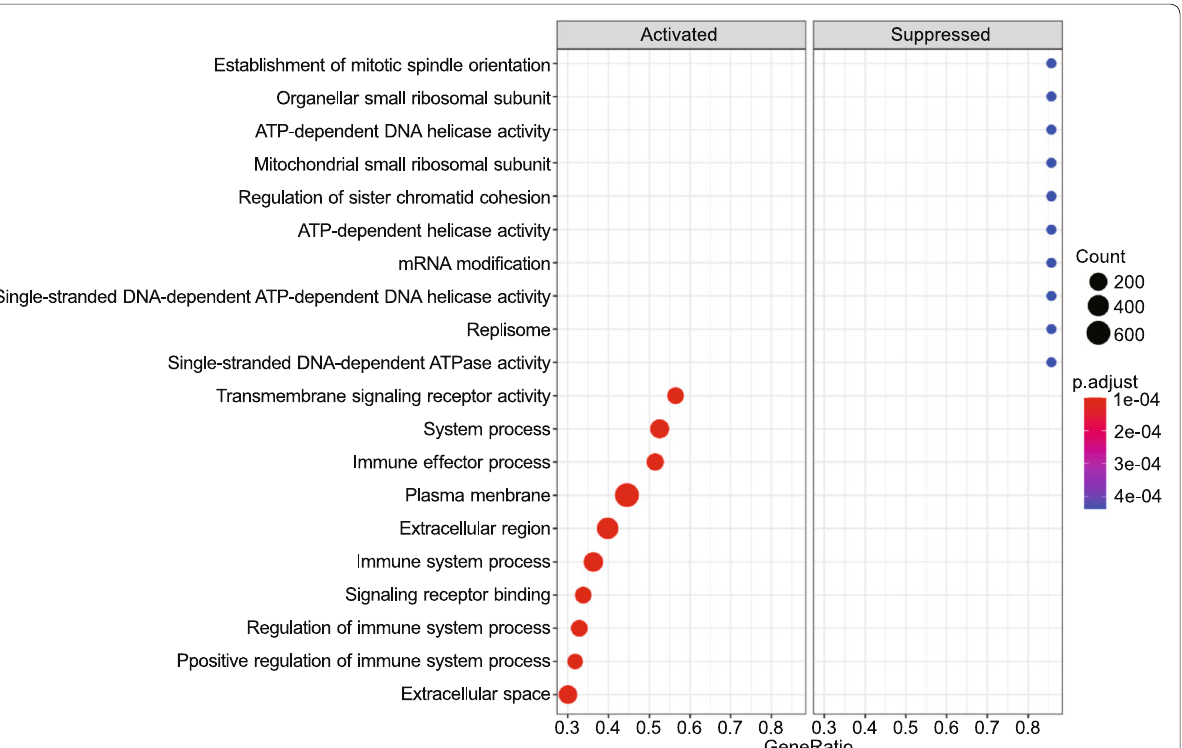
Fig. 4 Functional enrichment analysis of the Differentially expressed genes in human brain microvascular endothelial cells (hBMECs) at 12 hpi. Gene ontology terms plotted in the order of gene ratio, the size of the dots depicts the number of the gene counts that were significantly enriched in the GO list, the dot color represents the p -adjusted value (padj ≤